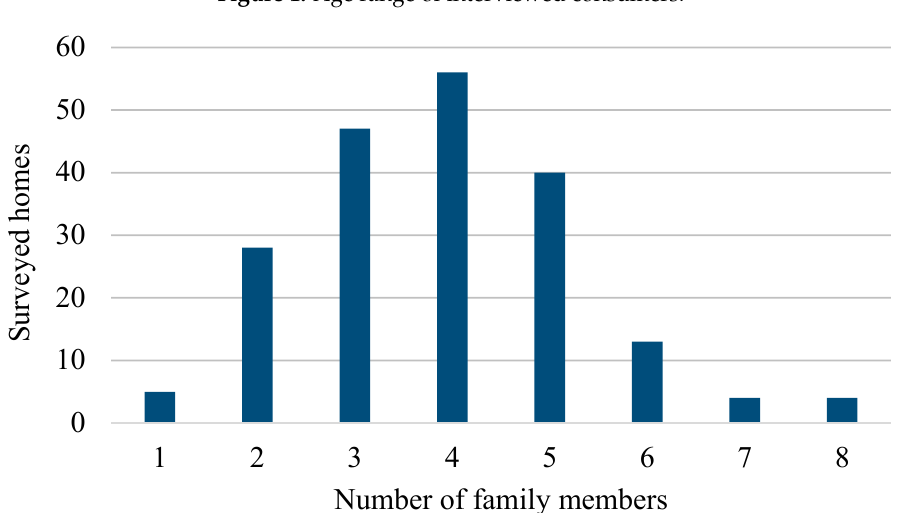
Figure 2. Number of family members in the surveyed homes.